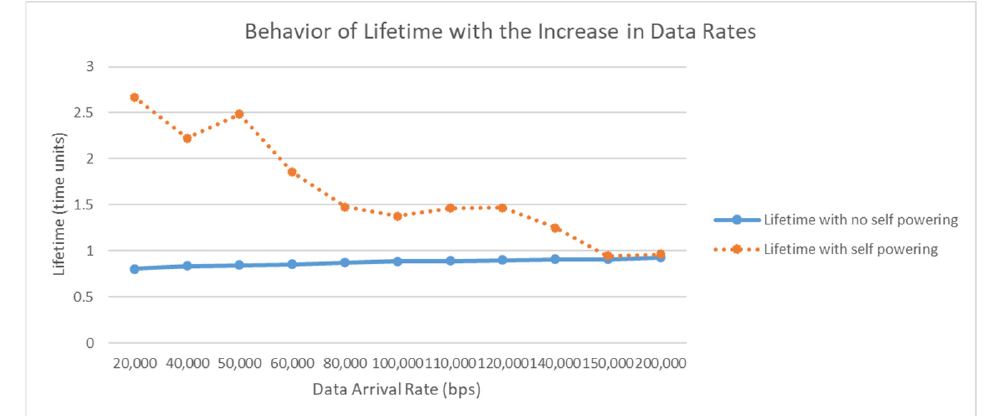
Figure 9. Improvement in network lifetime.